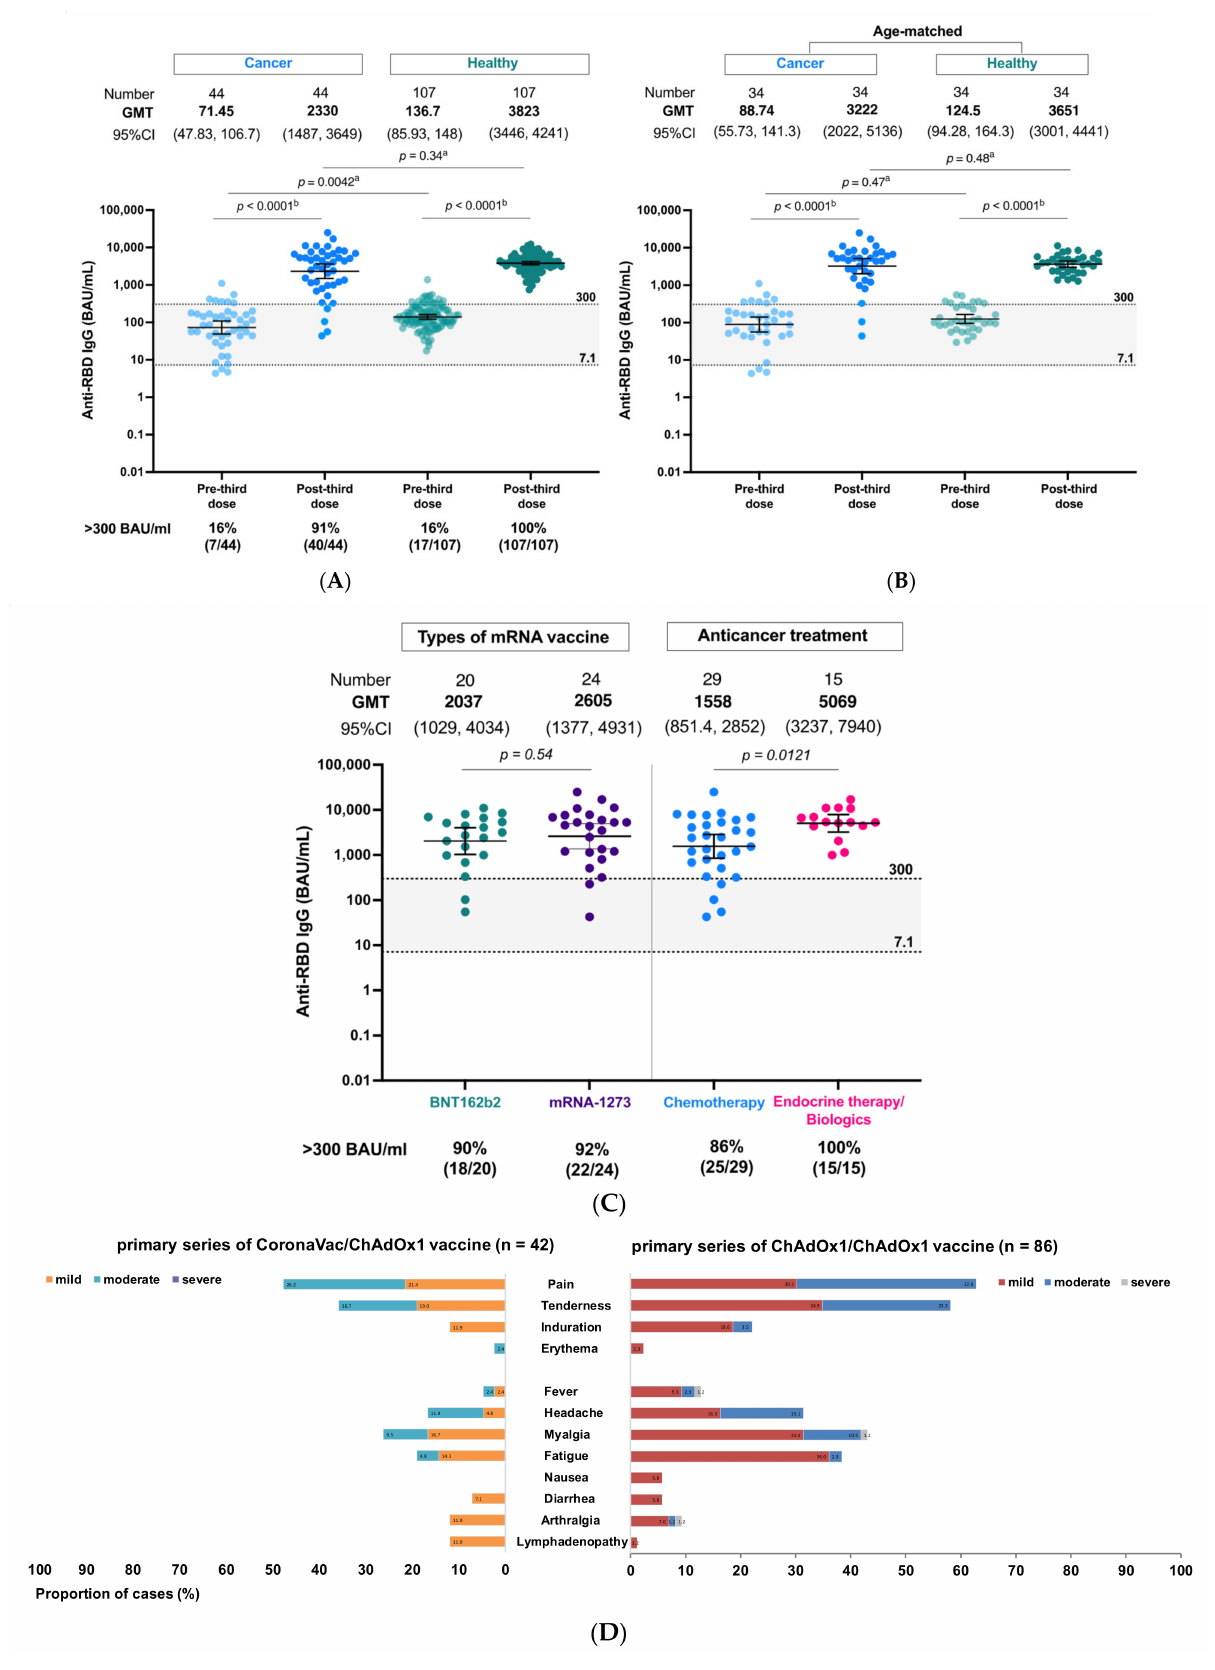
Figure 2. ( A , B ) SARS-CoV-2 binding antibody response SARS-CoV-2 binding antibody response at post-third mRNA COVID-19 vaccine following the heterologous CoronaVac/ChAdOx1